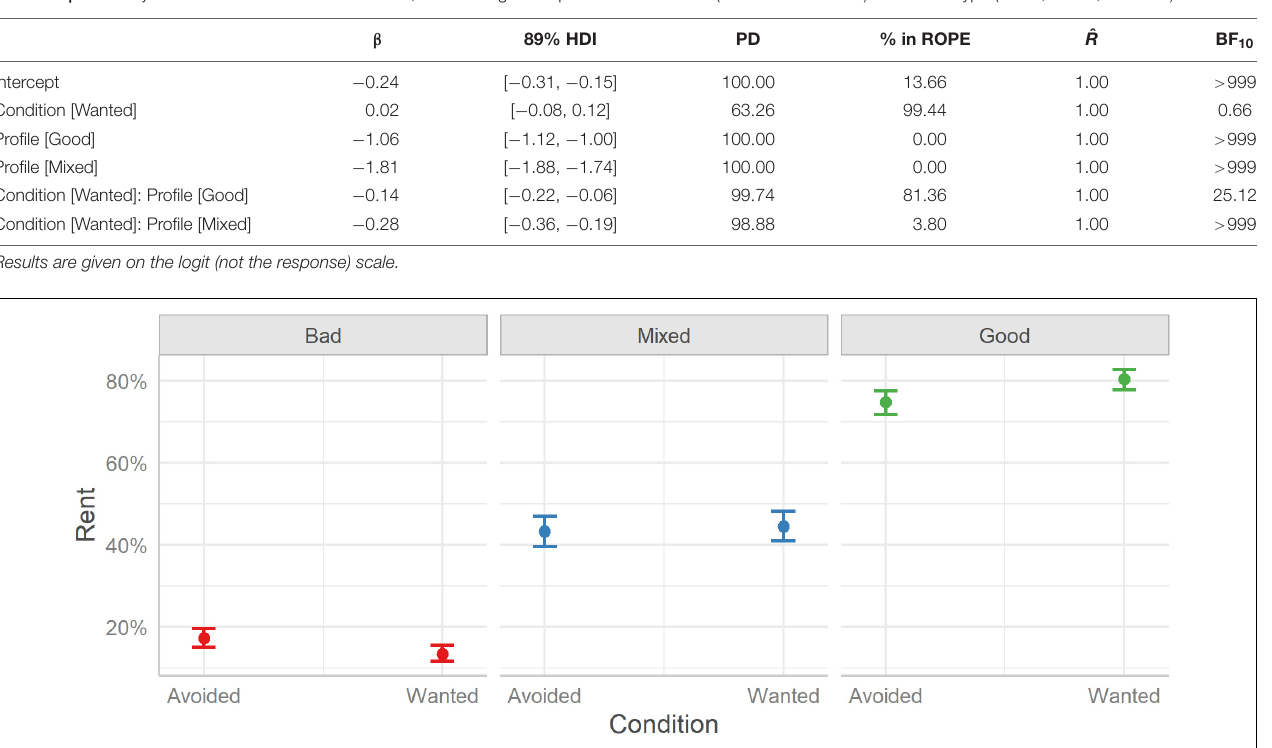
TABLE 9 | Summary of the model fitted to the rent data, considering the experimental condition (Wanted or Avoided) and Profile type (Good, Mixed, and Bad).